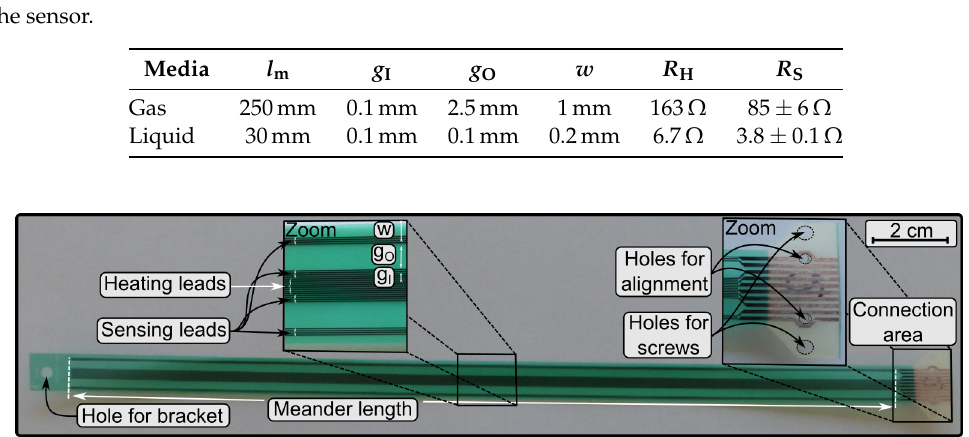
Figure 1. Image of the sensor layout with a meander length l m of 250mm. The left inset shows the copper leads (dark stripes) in detail: In the middle there is the heater and above and below there are the four sensing leads; g I , g O , and w denote the geometrical parameters (see Table1). The right zoom section shows the interconnection area of the sensor with holes for alignment pins and screws. The substrate is coloured beige and the solder resist is coloured green. On the left end, there is a hole for a bracket to fasten the sensor to the